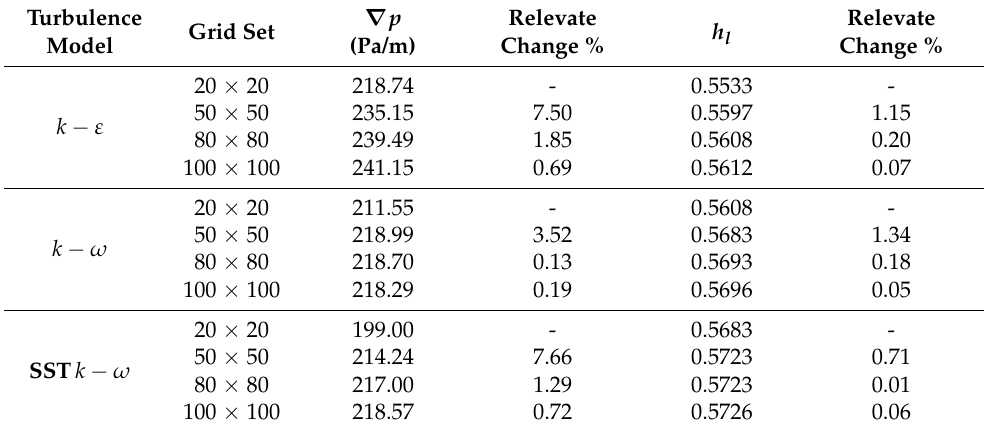
Figure 4. Comparison of the velocity distribution at vertical centerline on different grid sets. Table 1. Compare the effect of the number of grids on the pressure gradient ∇ p and dimensionless oil–water interface height h l for different turbulence